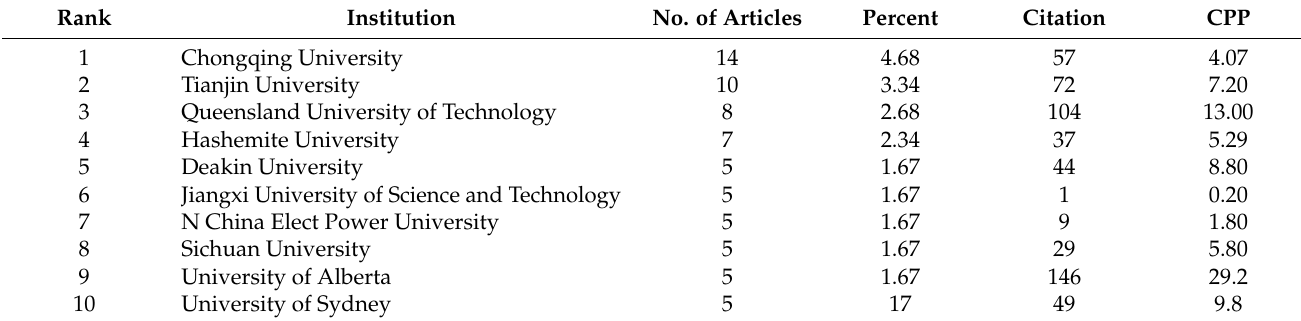
Table 5. Top 10 institutions with the highest number of articles in